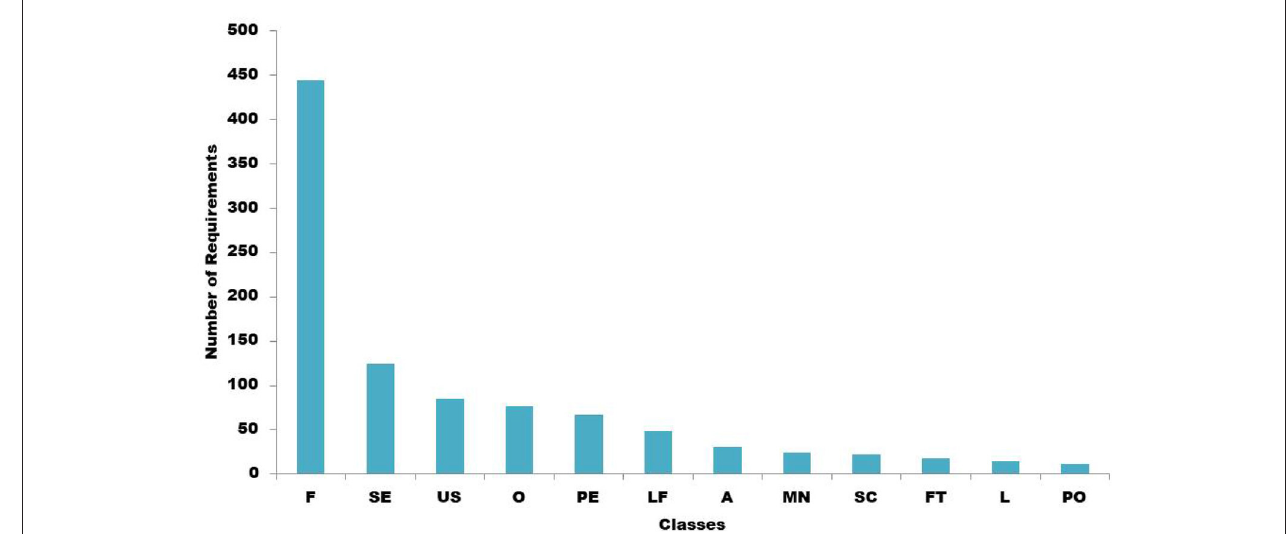
FIGURE 3 | Distribution of requirement